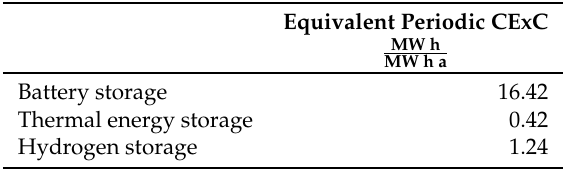
Table A8. Equivalent periodic CExC for storage